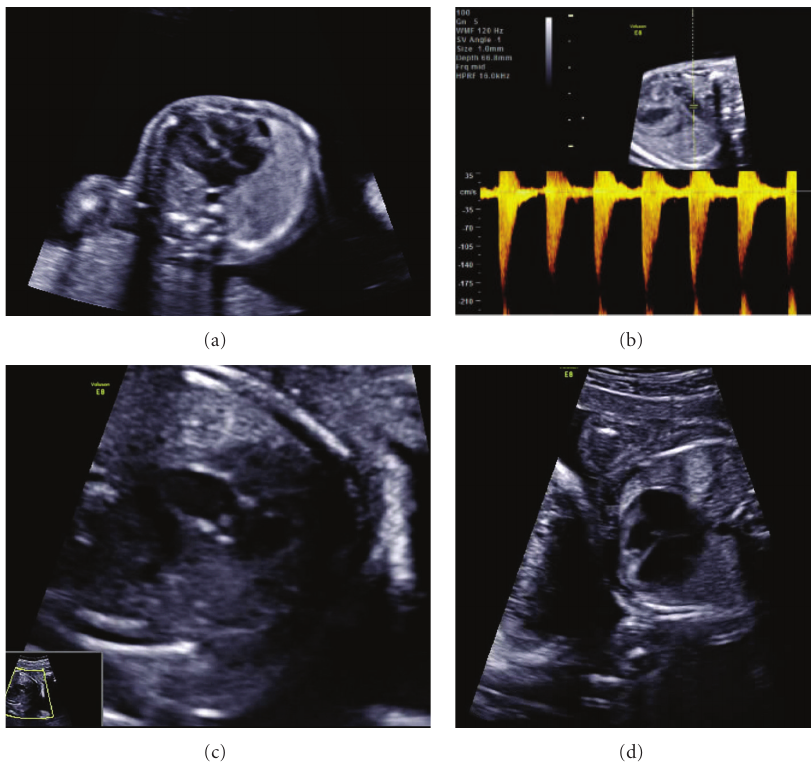
Figure 1: (a) Ultrasound examination at 21 weeks GA shows a four chamber view with a very mild right ventricle hypertrophy and mildly pericardial e ff usion. (b) Ultrasound examination at 21 weeks GA shows an elevated peak systolic velocity across the pulmonary valve of 1.75m/s. (c) Ultrasound examination at 21 weeks GA shows the pulmonary valve with a mild post stenotic dilatation. Valve cusps and pulmonary wall were echogenic and thickened. (d) Ultrasound examination at 28 weeks GA shows RV remains adequate, mild